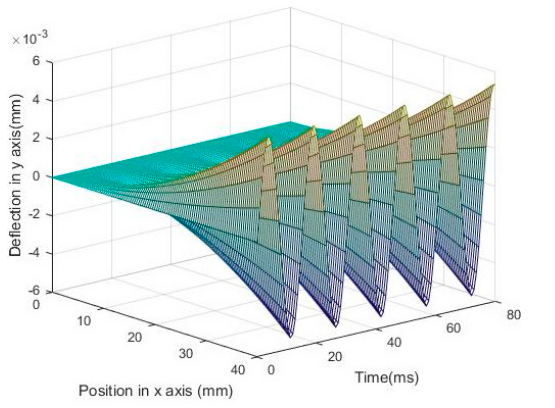
Figure 8. Voltage versus excitation acceleration at nine group frequencies.